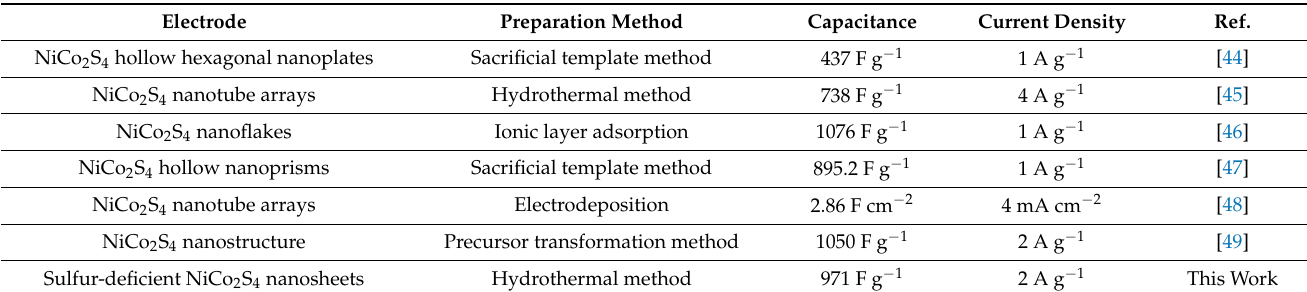
Table 1. Comparison of the specific capacitance of the sulfur-deficient NiCo 2 S 4 nanosheets